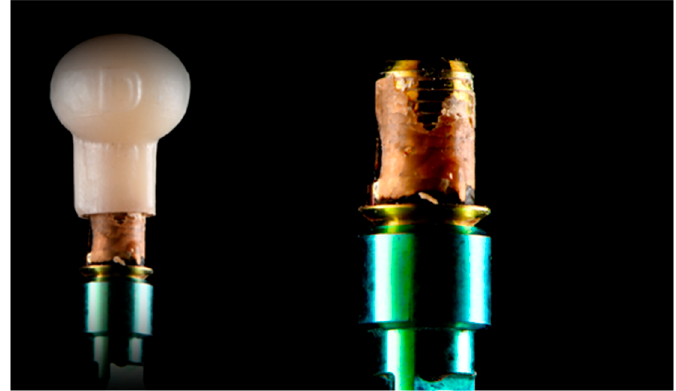
Figure 4. Titanium-base abutments immediately after the debonding procedure.